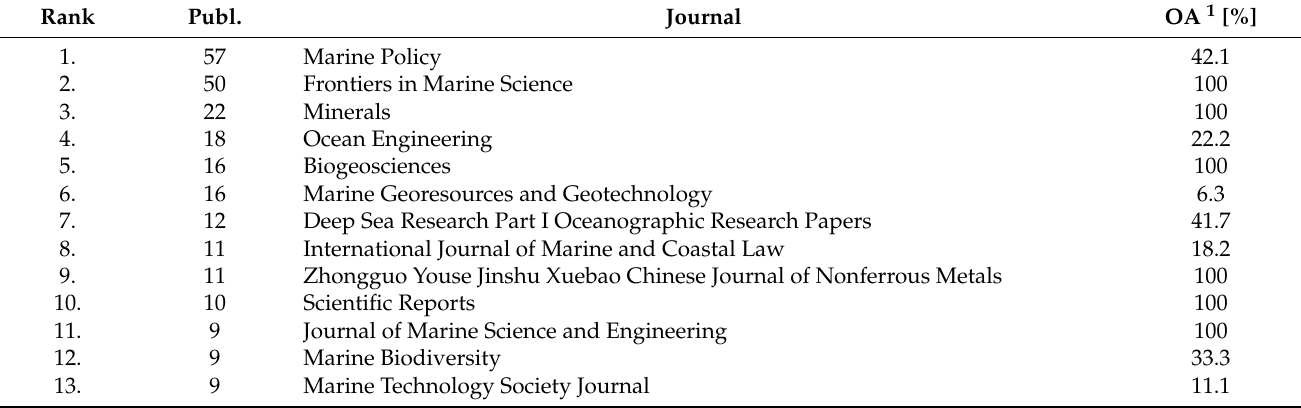
Table 7. Publication numbers and degree of OA publication for the top 13 journals